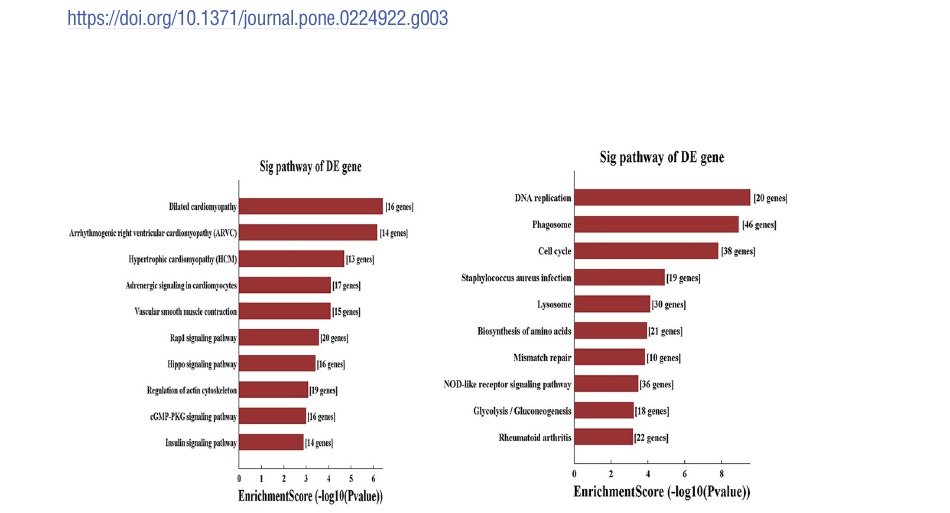
Fig 4. Significantly upregulated and downregulated